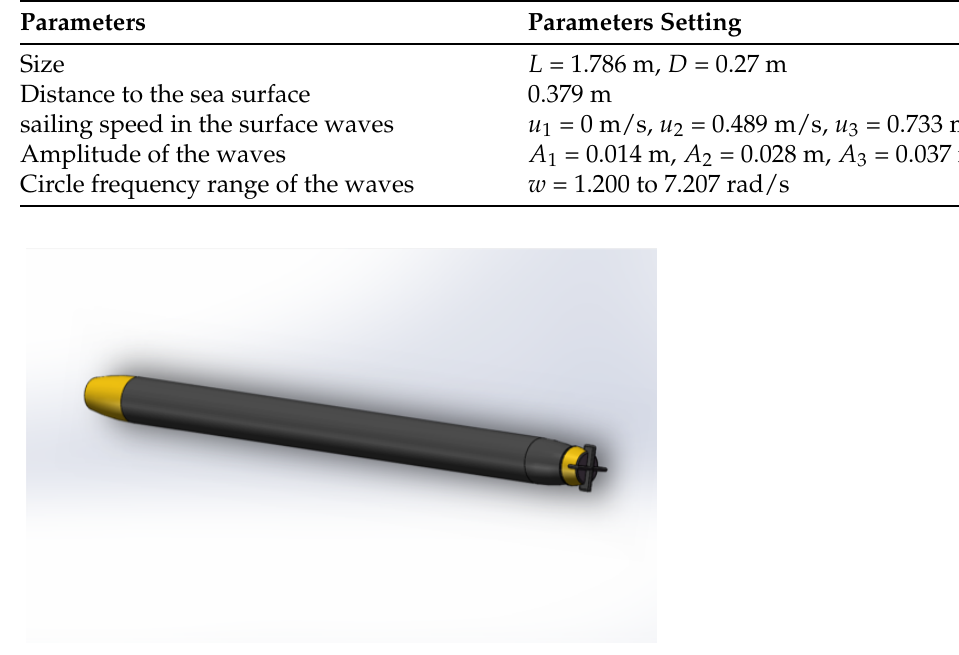
Figure 24. 3D model of the